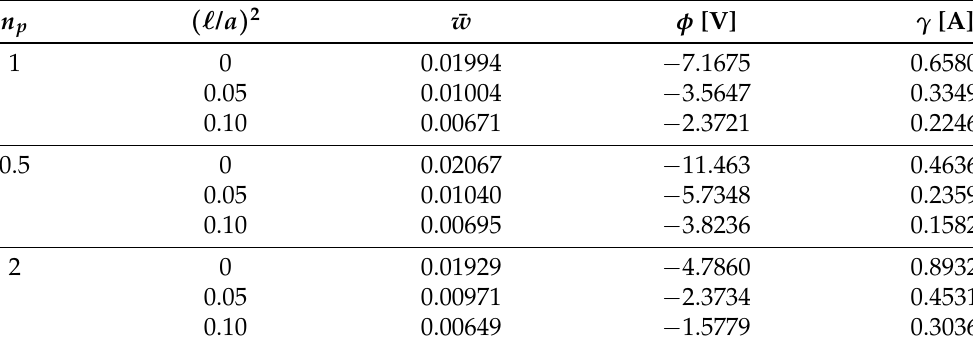
Table 2. Displacement ¯ w , electric and magnetic potential φ and γ , of a square nanoplate in central point ( a /2, b /2 ) for different values of nonlocal parameter ( (cid:96) / a ) 2 and n p (SDL; q = 10 3 N/m 2